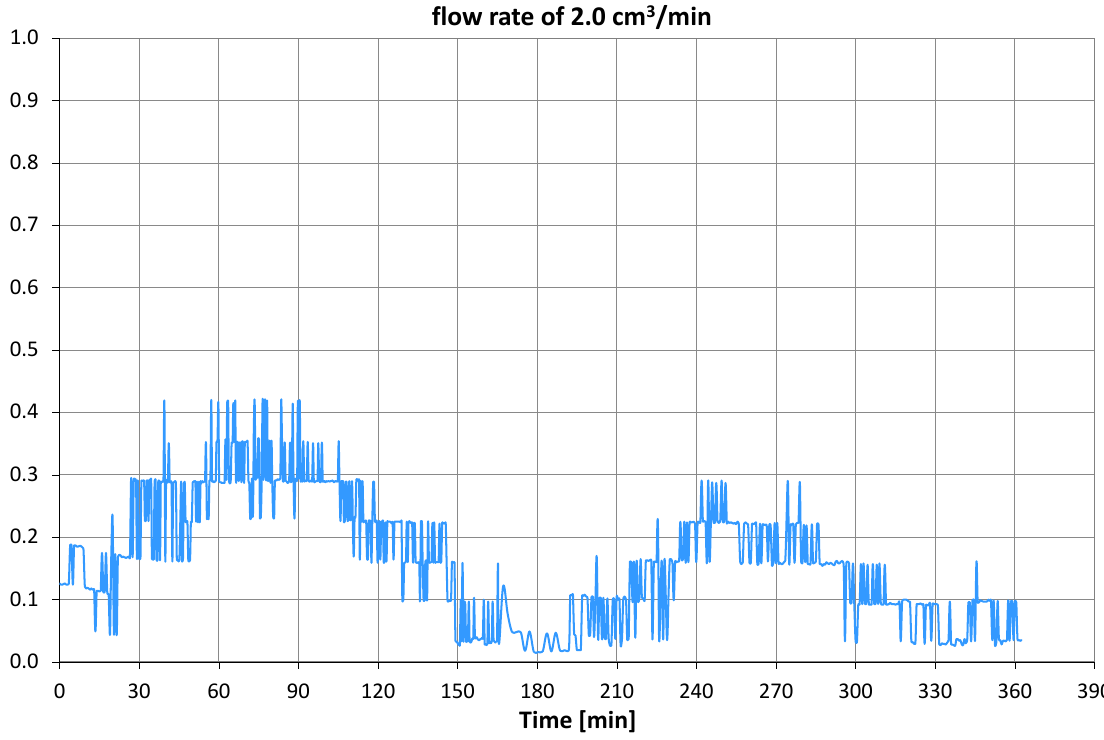
Figure 8. Long-term test of waters “A” and “B” under the following conditions: P = 40 bar, T = 120 °C and q = 2.0 cm 3 /min for each of the brine types (measurement error is ±4%). Table 2. Sediment precipitation in geothermal waters measurement results.